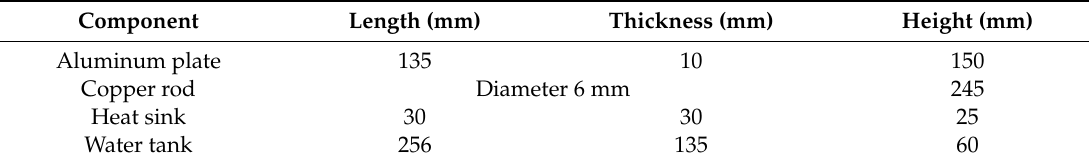
Table 2. Sizes of components.